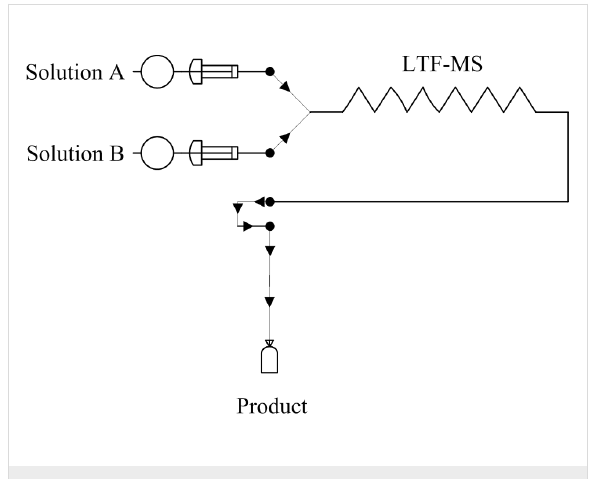
Figure 6: Schematic representation of the microreactor set